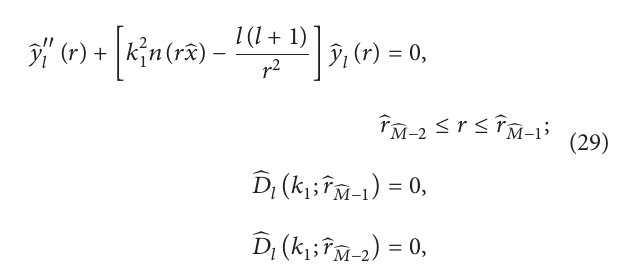
Figure 1: Rays of